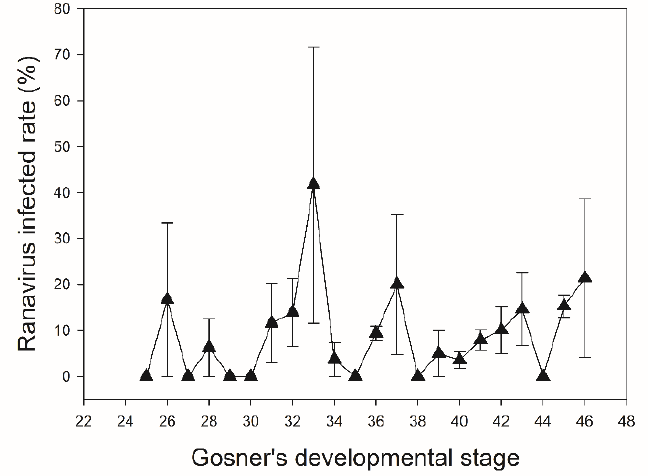
Figure 3. Changes in the ranavirus infection rate according to the Gosner developmental stage, based on combined data from larvae of three anuran species ( Dryophytes japonicus , Pelophylax nigro ‐ maculatus , Lithobates catesbeianus